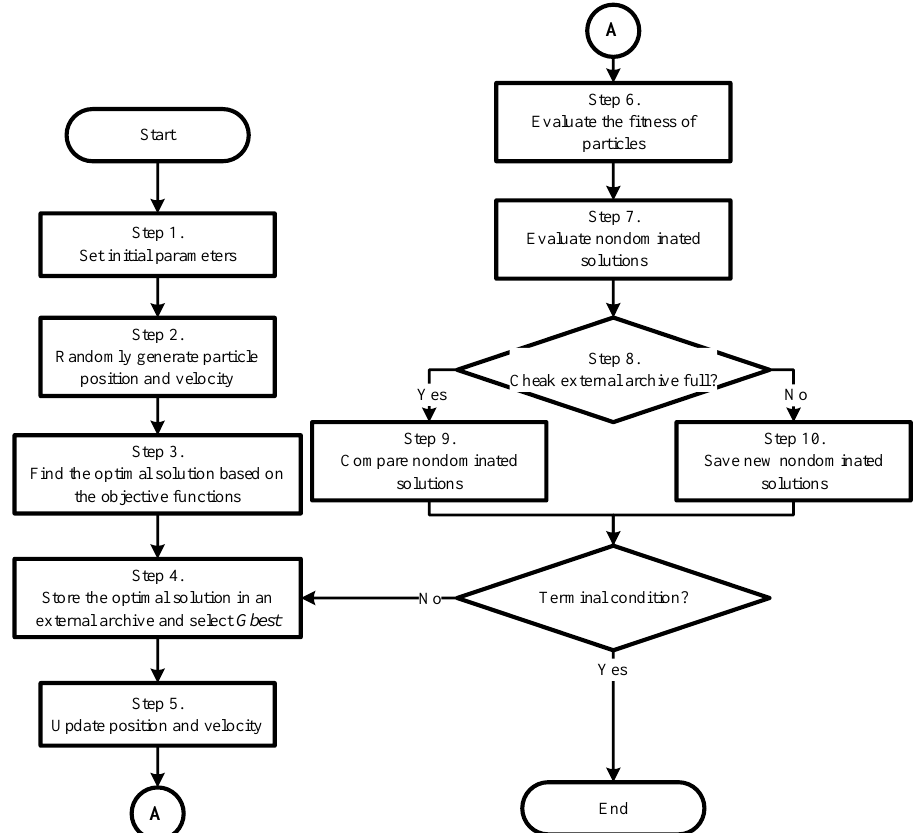
Figure 10. Flowchart of the proposed MOPSO algorithm.